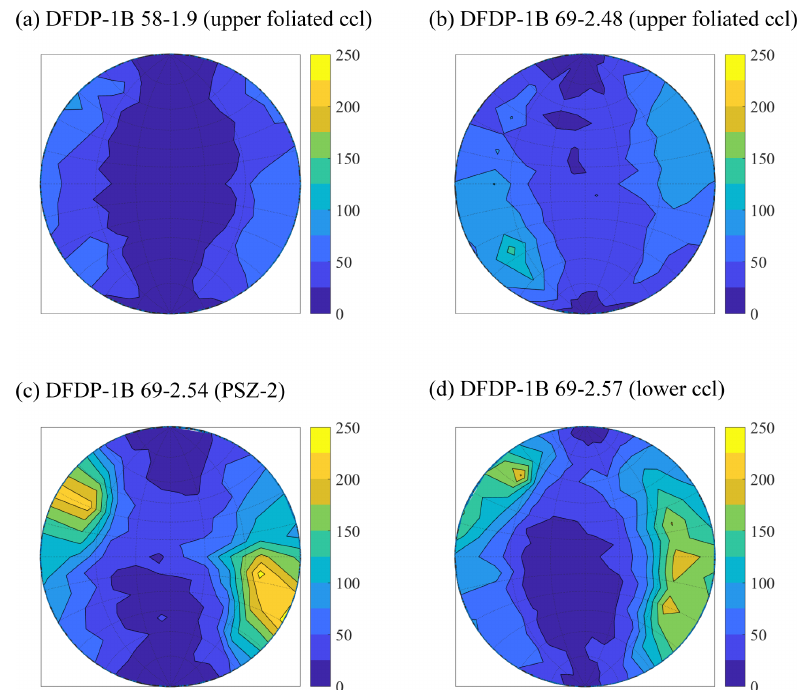
Figure 7. Distribution of pore unit orientations plotted on a lower-hemisphere equal-area stereographic projection with a probability density